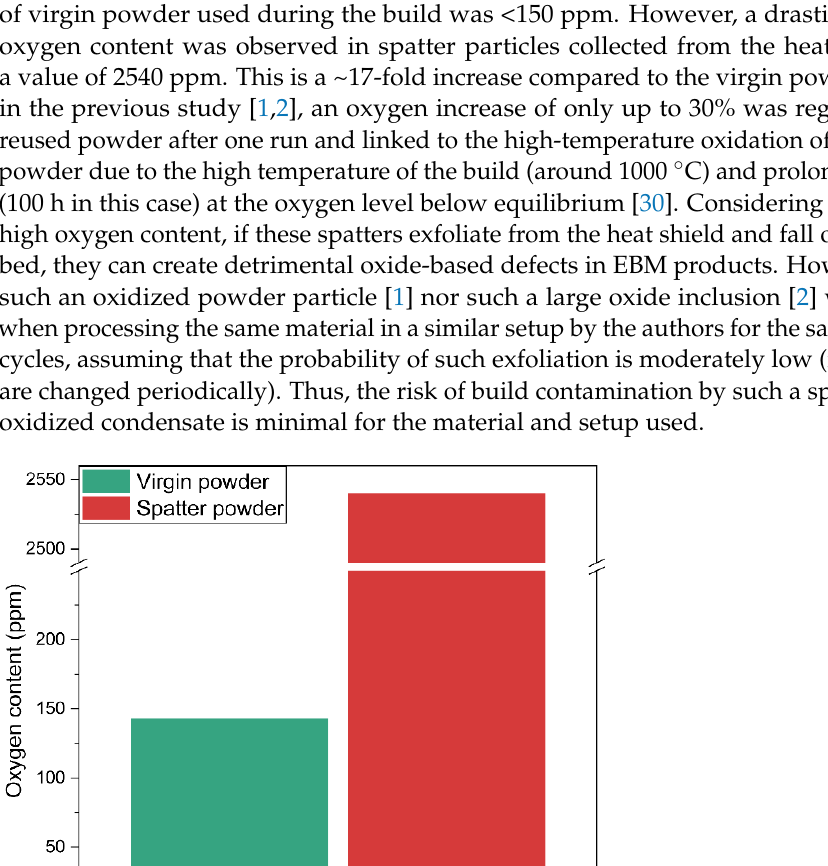
Figure 5. EDS line scan on highlighted yellow line in SEM micrograph.